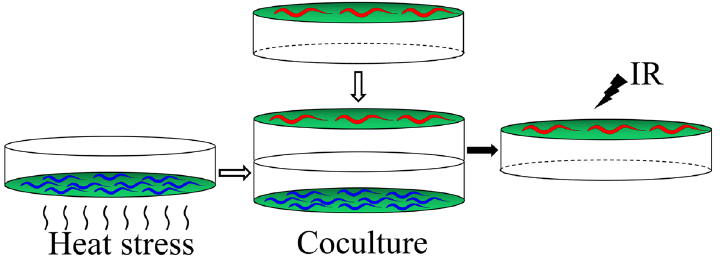
Figure 7. Schematic drawing of co-culture experimental system, in which red worms represent the top worms, blue worms represent the bottom worms, and the top worms communicate with the bottom via volatile